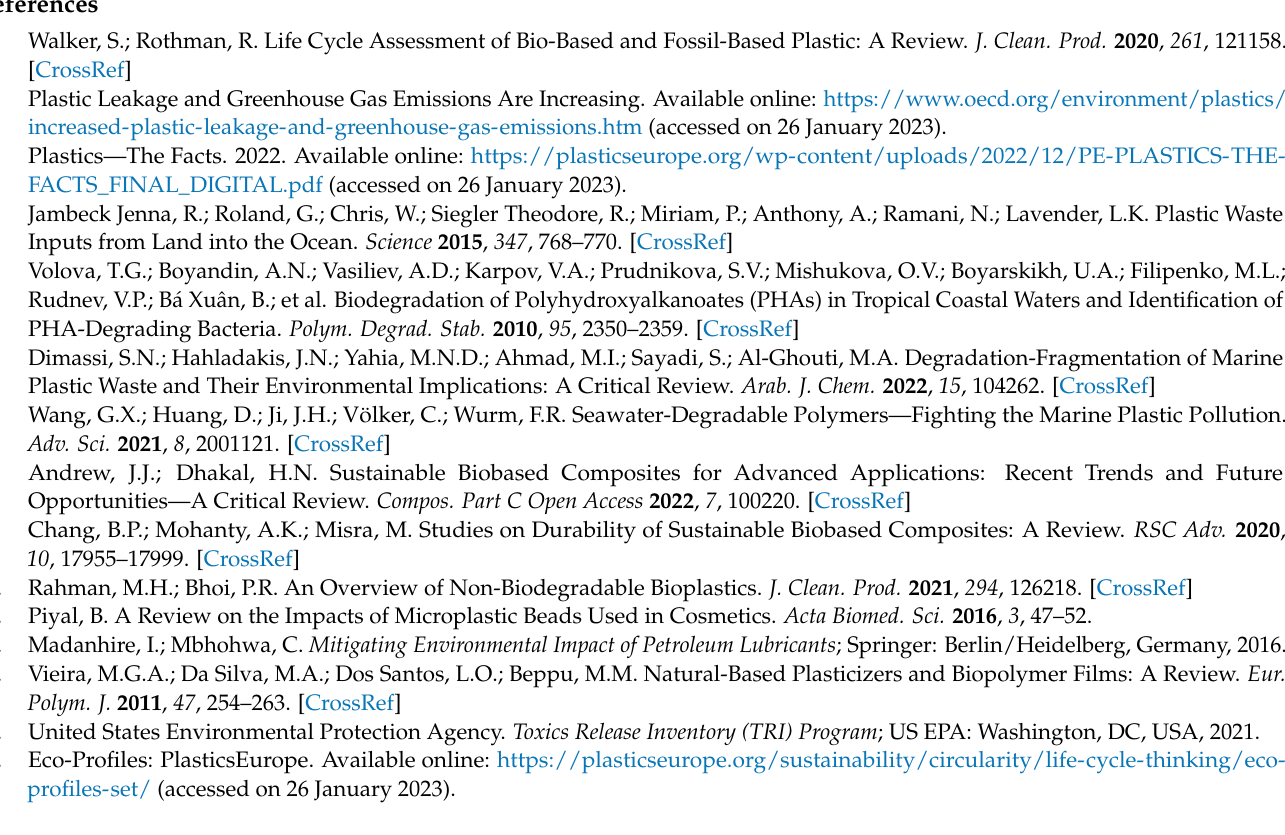
conversion into the epoxy product 9,10-epoxistearic acid is evident. Figure S9: GC-MS chromato- grams of (a) linoleic acid and (b) the reaction mixture after 3 h. Figure S10: GC-MS chromatogram of (a) linolenic acid and (b) reaction mixture. Figure S11: The thermogram of a co-oligoester con- taining AA-BDO units. Figure S12: The thermogram of sample ECOSORB. Figure S13: The ther- mogram of sample ECOBDO. Figure S14: Di ff erential scanning calorimetry (DSC) characterization curves of the (BDO-AA)n sample; cooling (red), 2nd heating cycle (blue). Figure S15: Di ff erential scanning calorimetry (DSC) characterization curves of the (Gly-AZA)n sample; cooling (red), 2nd heating cycle (blue). Figure S16: Di ff erential scanning calorimetry (DSC) characterization curves of the ECObdo sample; cooling (red), 2nd heating cycle (blue). Figure S17: Di ff erential scanning calo- rimetry (DSC) characterization curves of the Ecosorb sample; cooling (red), 2nd heating cycle (blue). Figure S18: Di ff erential scanning calorimetry (DSC) characterization curves of the EPX_OIL_C sample, cooling (red), and 2nd heating cycle